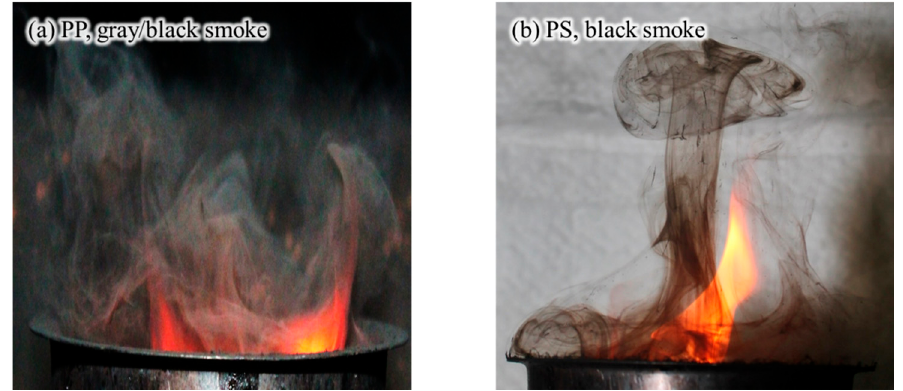
Figure 10. Photographs of smoke flow generated from burning of ( a ) PP and ( b ) PS pellets.